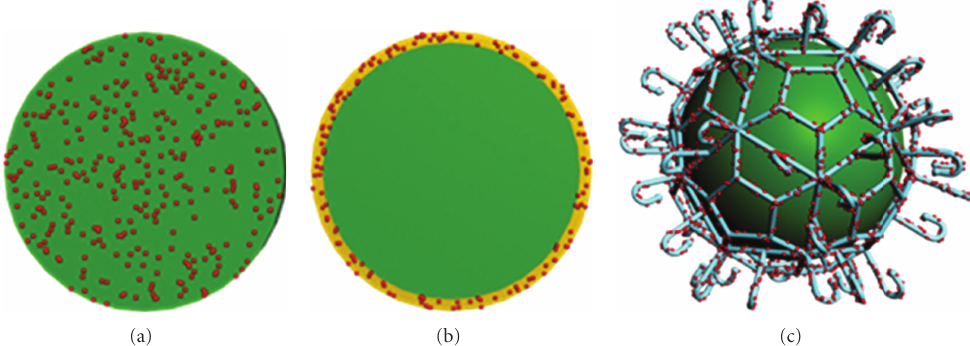
Figure 6: Enabling technologies for magnetic levitation of tissue spheroids. Three possible variants of modifications of tissue spheroids making them suitable for magnetic levitation: (a) biofabrication of tissue spheroid from cells labelled with magnetic nanoparticles; (b) encapsulation of tissue spheroid into hydrogel containing magnetic nanoparticles; (c) encaging tissue spheroid in magnetic microsca ff olds.